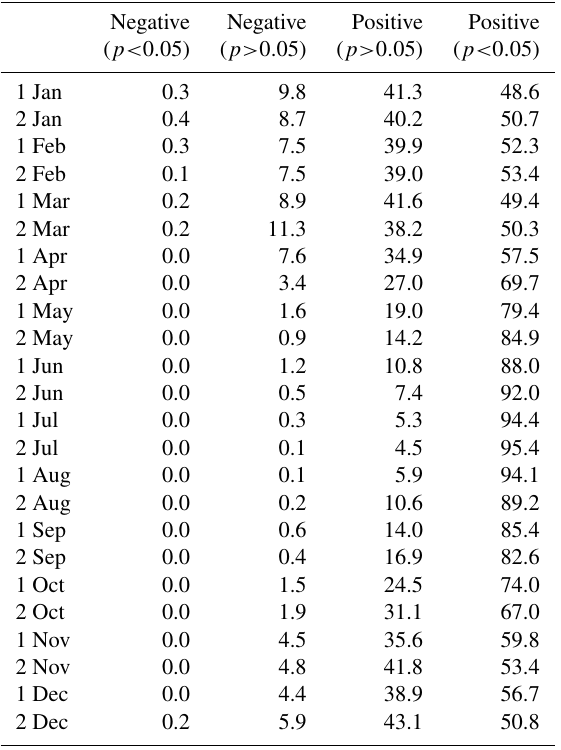
Table 1. Percentage of the total surface area according to the differ- ent significance categories of Pearson’s r correlations between the sNDVI and